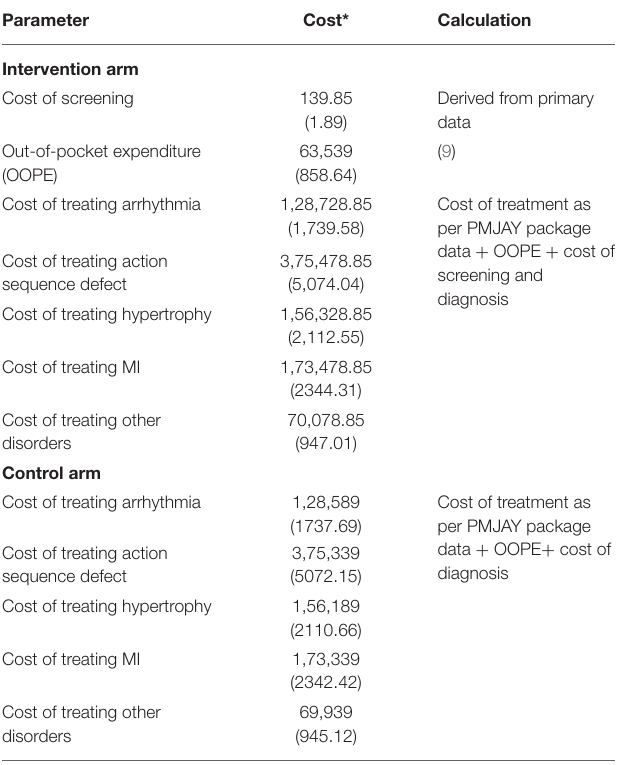
TABLE 3 | Cost data used to populate the model for high risk